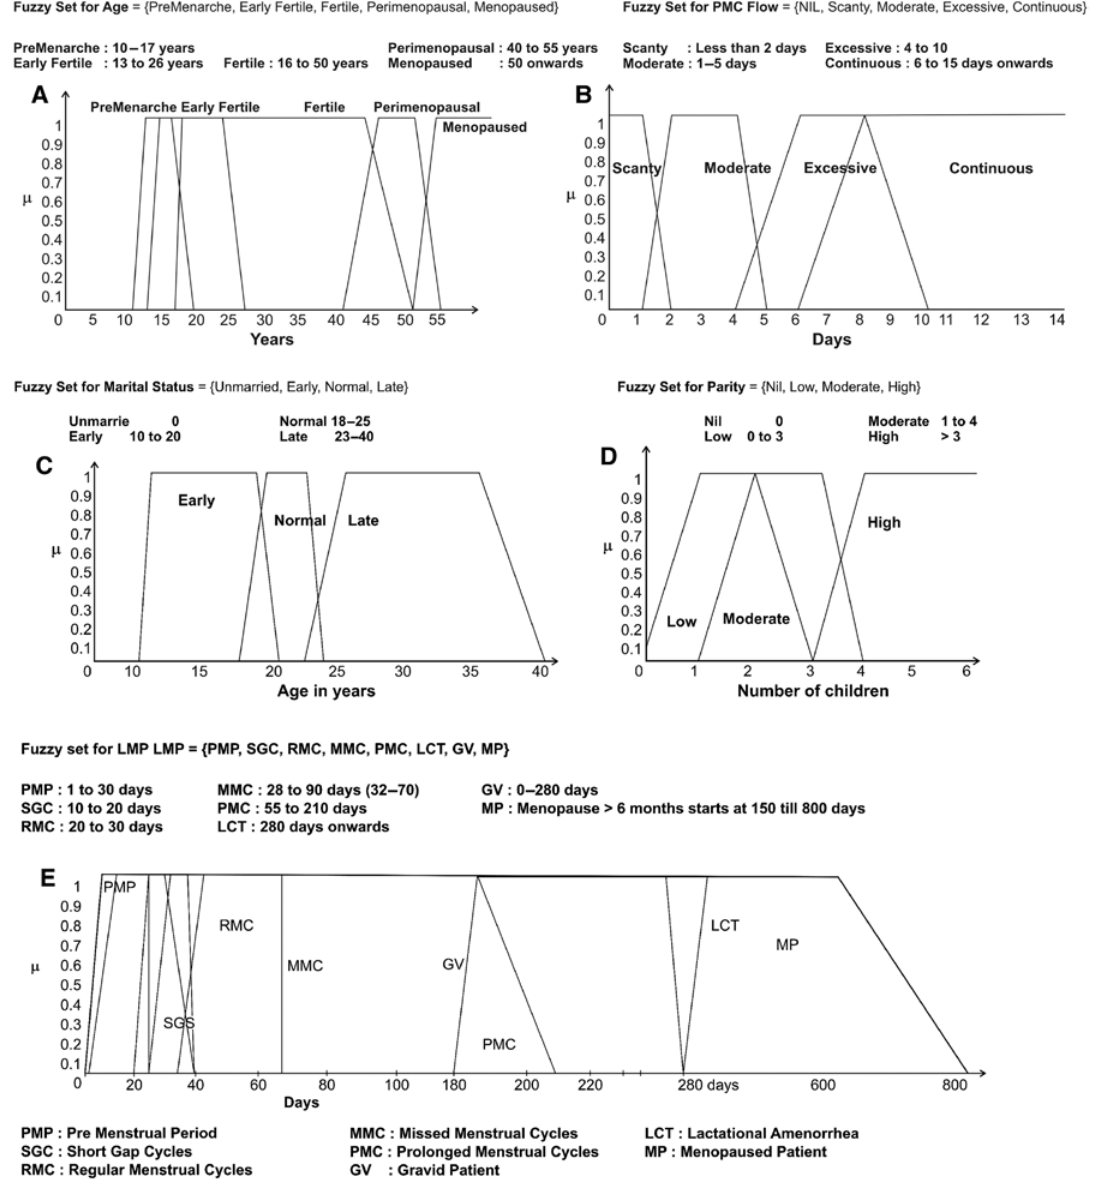
Figure 2: (A–E) Fuzzy Sets for History Parameter. (A) Fuzzy set for age. (B) Fuzzy set for PMC_Flow. (C) Fuzzy set for Marital_ Status. (D) Fuzzy set for parity. (E) Fuzzy set for